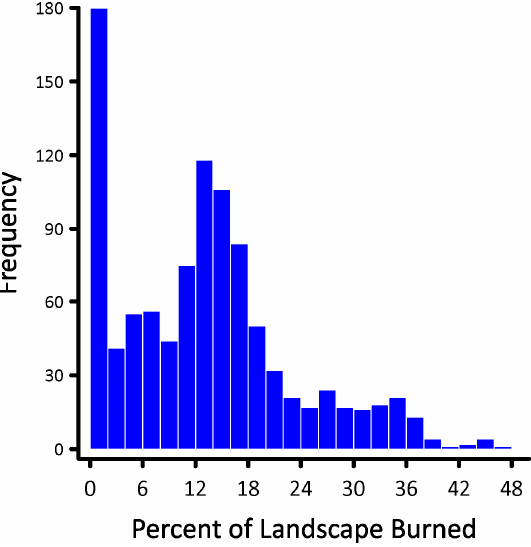
Figure 7. The emergent distribution of burn areas observed from 1000 fire simulations. Replicates that generated a fire size of less than 100 hexagons (of 119 K hexagons total) were replaced with the results from an additional simulation.